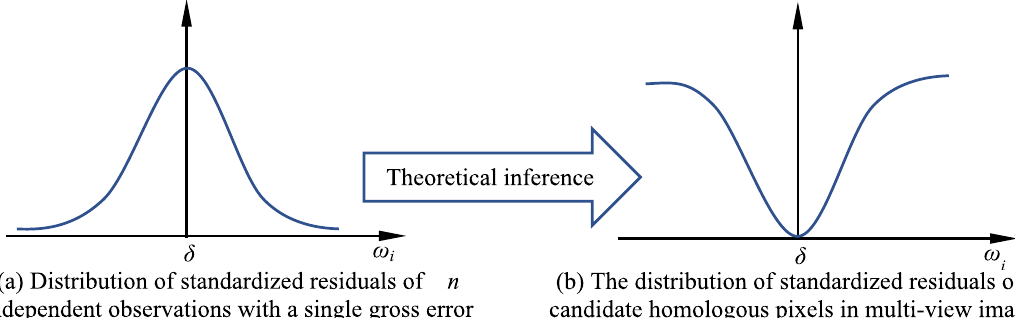
Figure 3. The theoretical inference on the positional distribution pattern among candidate homologous pixels in multi-view images according to the surveying adjustment Analysis of the positional distribution pattern among candidate homologous pixels based on